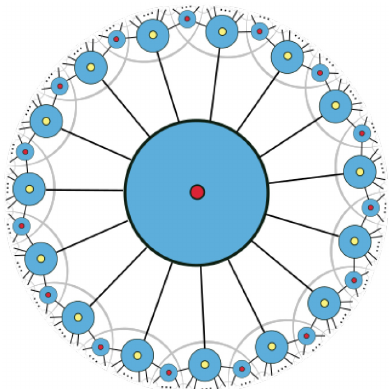
FIG. 12. A holographic Reed-Muller code with transver- sal non-Clifford gate. The ellipsis represents the remaining boundary-facing legs that we drop to avoid clutter. Dangling logical legs in the bulk are denoted as red or yellow dots.